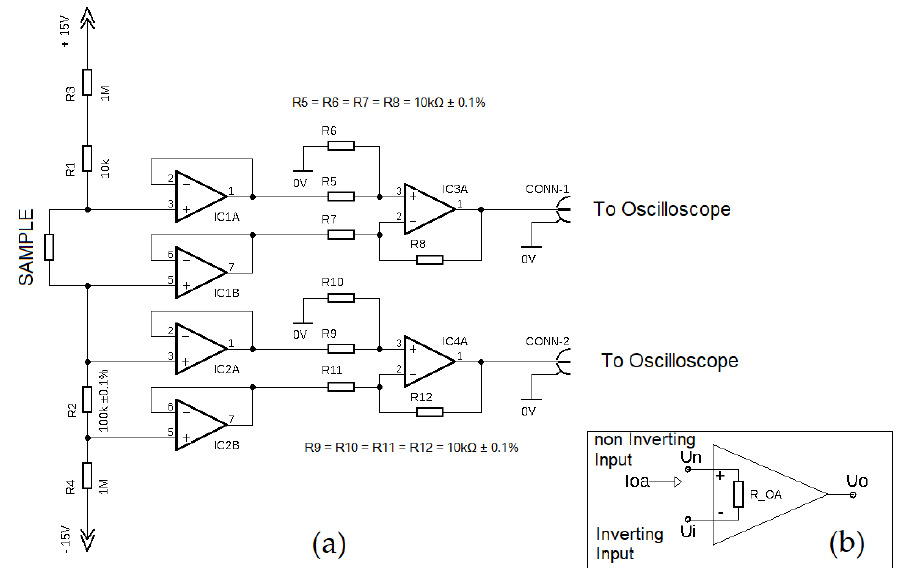
Figure 3. ( a ) The electric scheme of measurement; ( b ) operational amplifier.